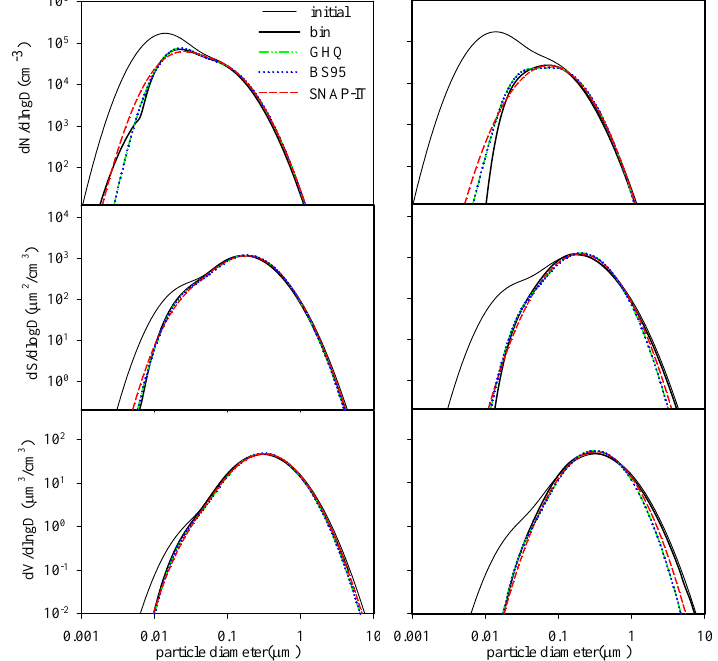
Figure 10: Simulation of the evolution of size distribution due to Brownian coagulation using SNAP-IT (red dashed curve), BS95 (blue dotted curve), GHQ (green dash-dotted curve) and binned model (thick black curve). Thin solid curves indicate the initial size distribution. The left and right panels are 1h and 6h results, respectively. Panels from top down are the number, surface area, and volume density distributions.